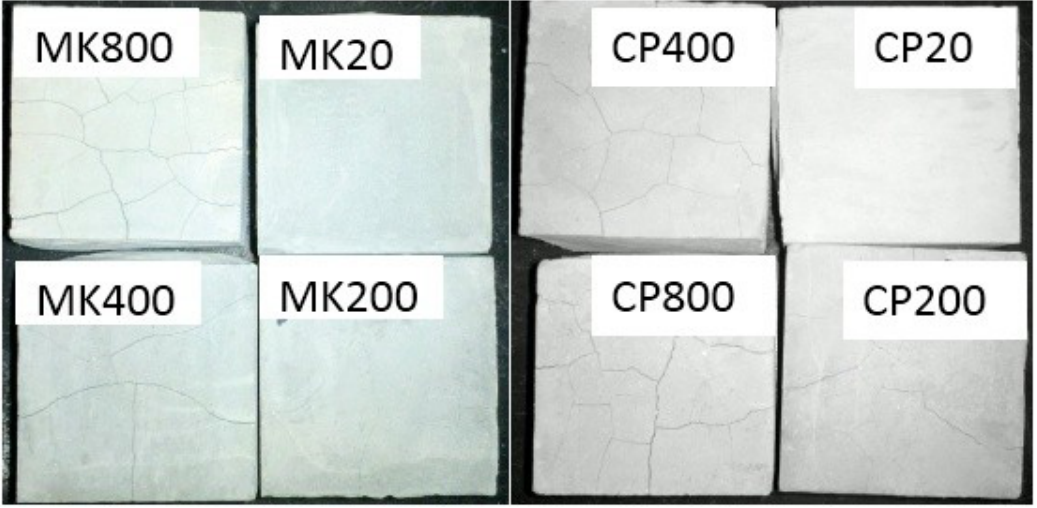
Figure 4. The appearances of cement–metakaolin paste and pure cement paste at different temperatures.